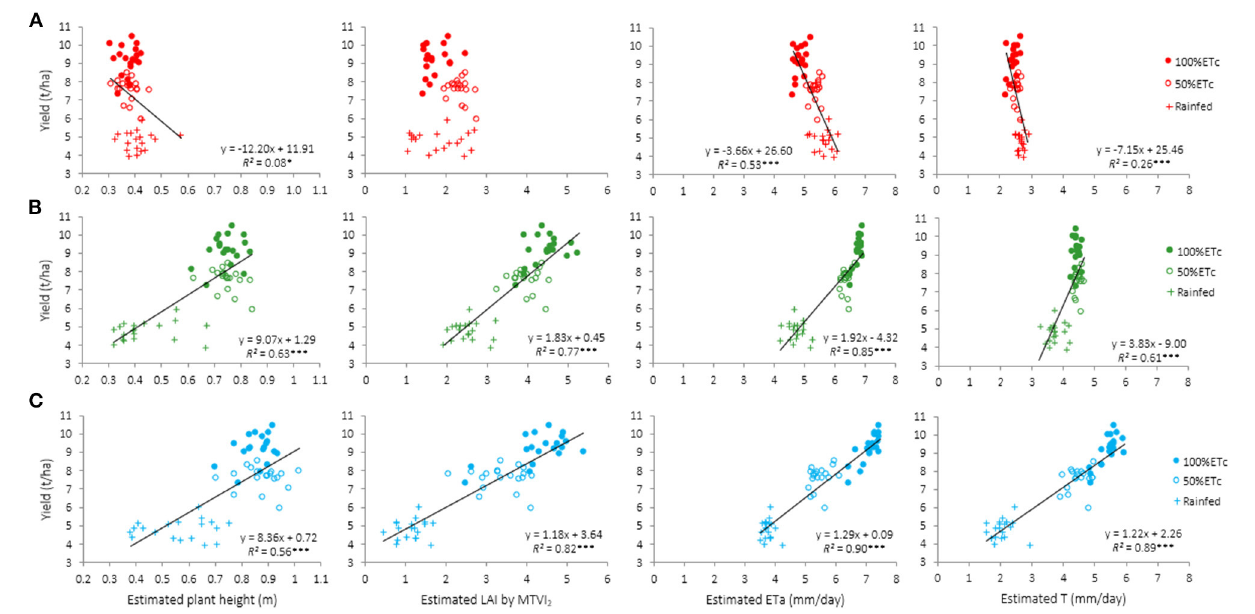
FIGURE 7 | Relationships between estimated plant height, LAI, actual evapotranspiration (ETa), and transpiration (T) assessed from remote sensing imagery and yield for the three irrigation treatments (full circles, 100%ETc; empty circles 50%ETc; (anthesis), and (C) May 22nd (grain filling). Each point represents the mean value of a genotype across replications ( n